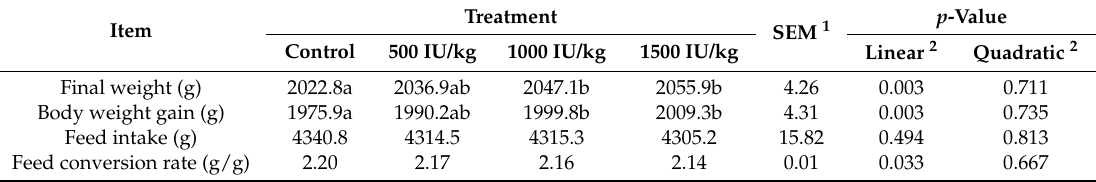
Table 1. Effects of dietary optiXynB on growth performance of broilers.